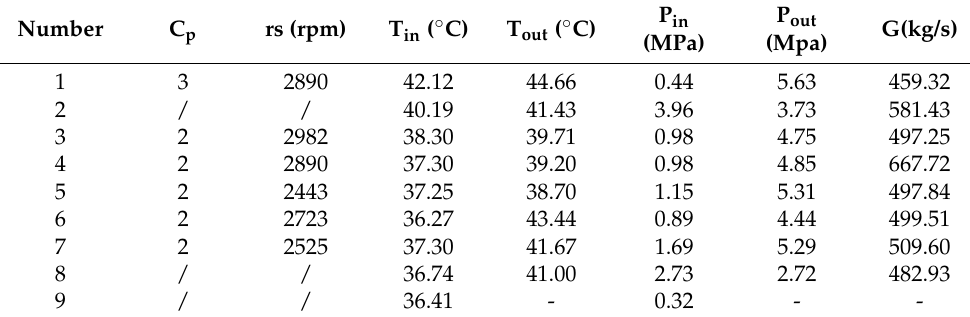
Table 7. July actual operation scheme.